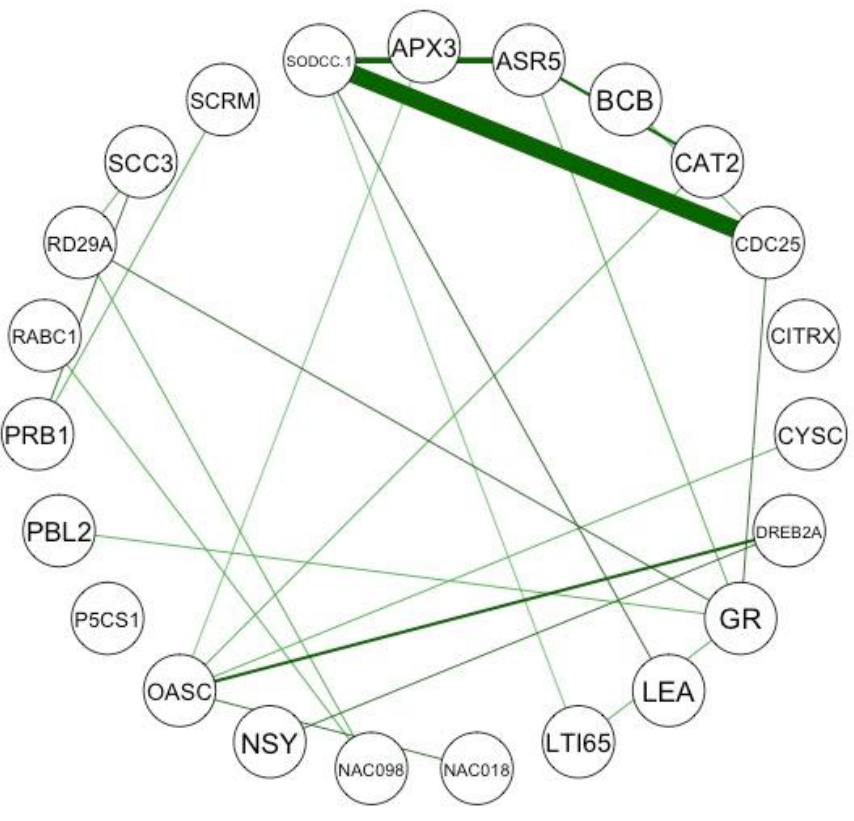
Figure 4. An internal relations networks showing the genes by number of abstracts with at least one occurrence of them shared with other species over a 50% threshold. Genes that appear together in abstracts more often have a wider and more deeply colored bar linking them. Internal relations networks were also produced for the taxonomical and phenotype results but are not shown here. This figure was produced by the functions InternalPairwiseDistanceInferreR and TopN_PickeR_Internal functions from G2PMineR and the qgraph function from qgraph.